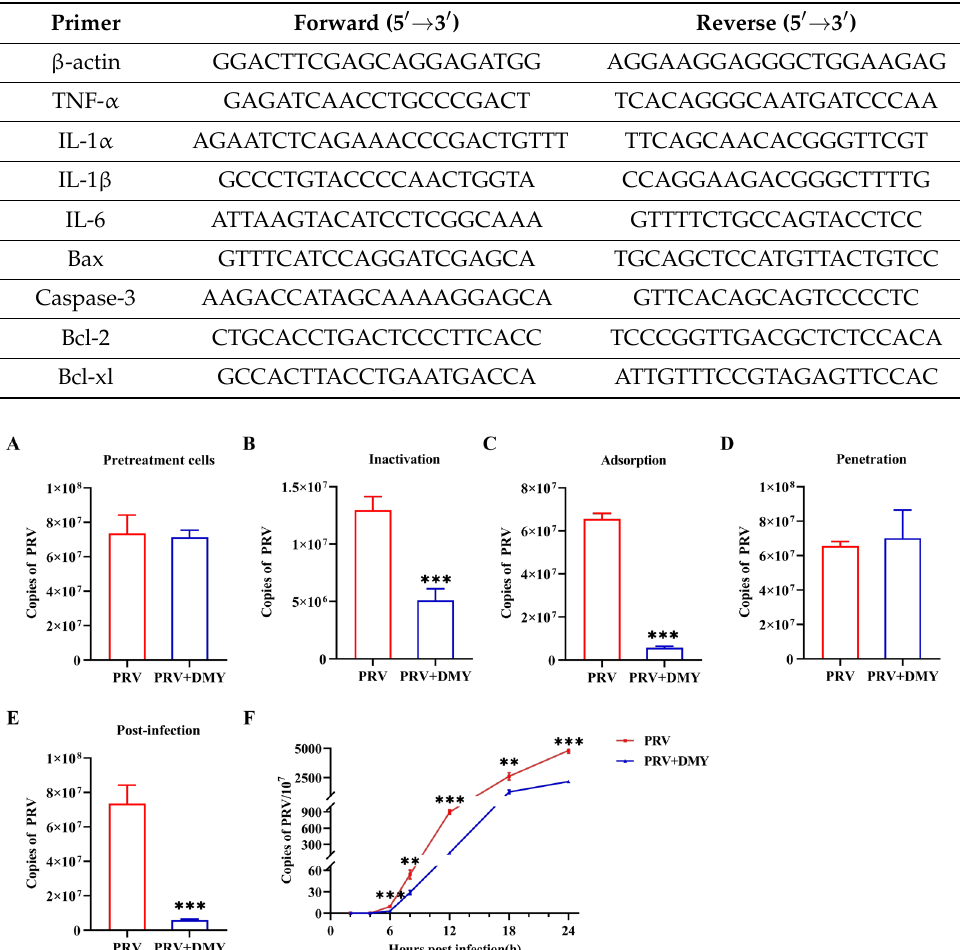
Table 1. Primer sequences for real-time PCR.